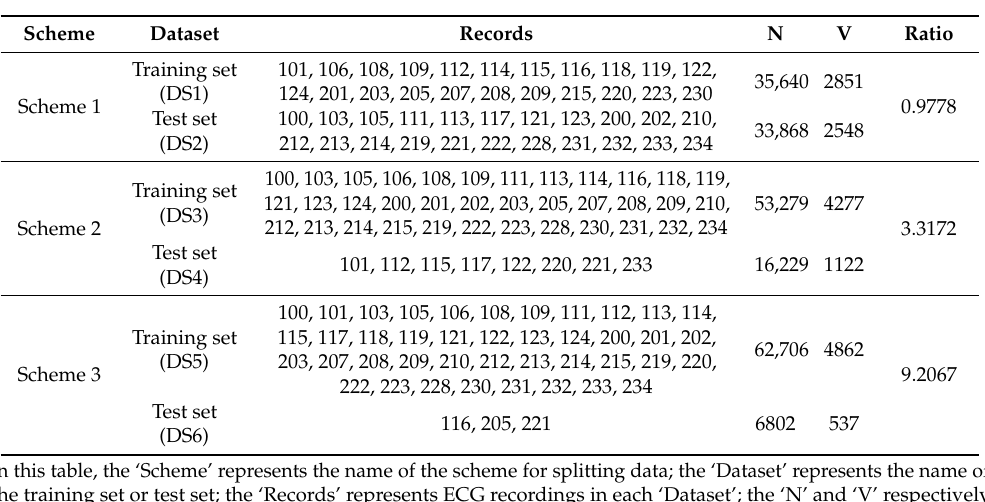
Table 2. Splitting data into training and test sets.